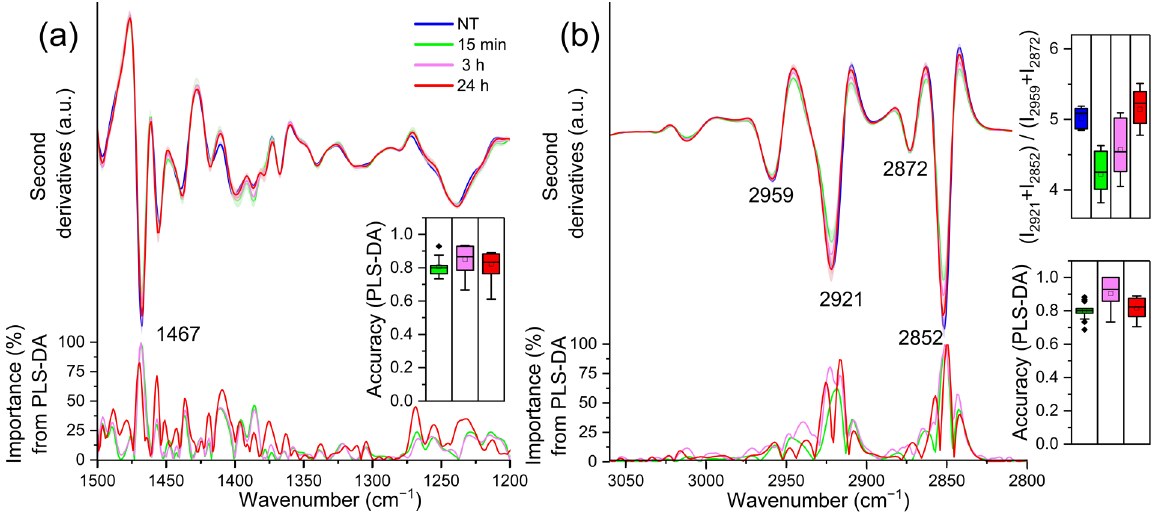
Figure 3. Mean second derivative spectra in the 1500–1200 cm − 1 ( a ) and 3050–2800 cm − 1 ( b ) ranges of TDM cells before (0 h) and at different time points of LPS treatment. Standard deviation has also been displayed as a shadowed area. Below, the wavenumber importance for PLS-DA discrimination performed in the selected spectral range is shown for each panel. In the insets, the PLS-DA discrimination accuracy (panels a and b ) and the intensity ratio among the CH 2 and the CH 3 peaks (panel b ) are reported. Box plots are given as in Figure 1.